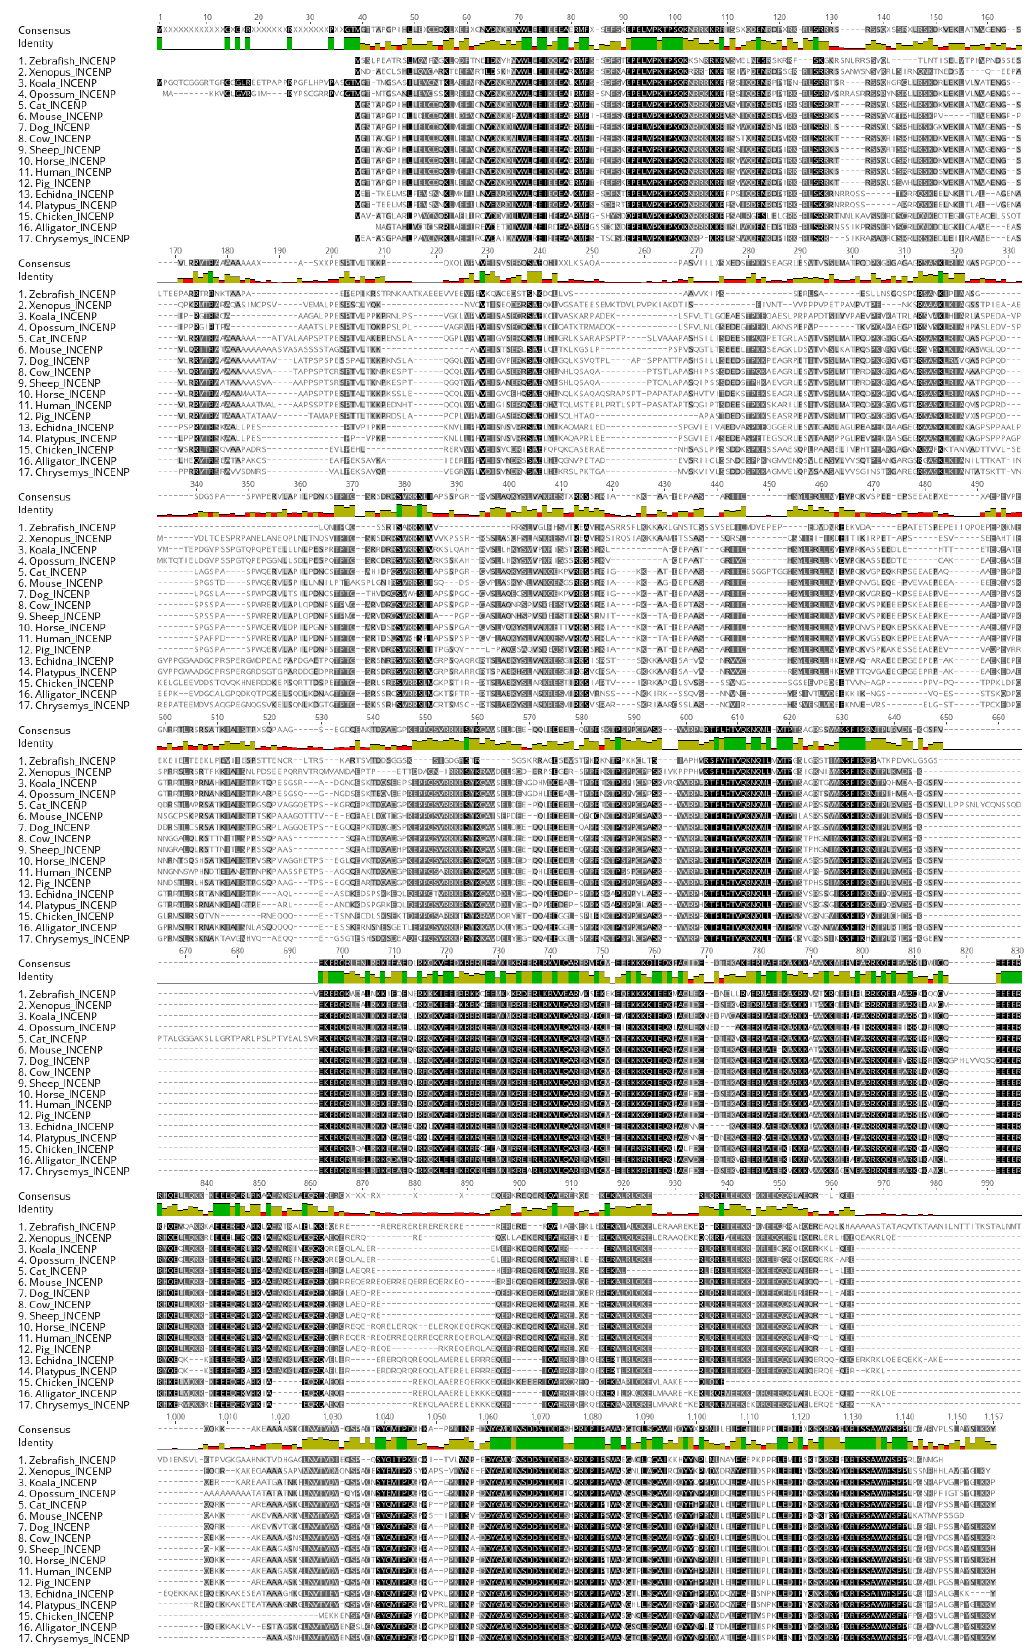
Figure A2. INCENP alignment. Alignment of amino acid sequences of INCENP from various vertebrate clades. The pairwise identity of this protein for given organisms is 52.4%.